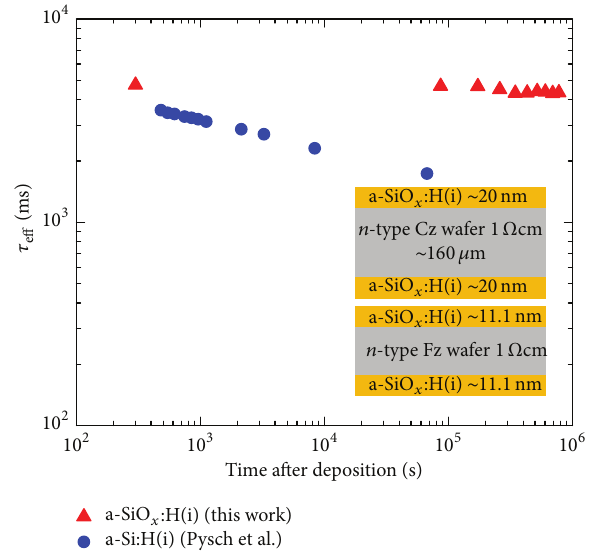
Figure 13: Effective lifetime as a function of time after deposi- tion. The insets show sample structures and dimensions for both materials used in the degradation study. The passivation quality of a-SiO 𝑥 :H(i) film (20 nm) hardly degrades even after one week of storage. As a comparison, lifetime degradation data of ICP a- Si:H(i) [24] (11.1nm) is superposed in the same graph. The a- Si:H(i) passivation layer shows constant degradation of lifetime immediately after